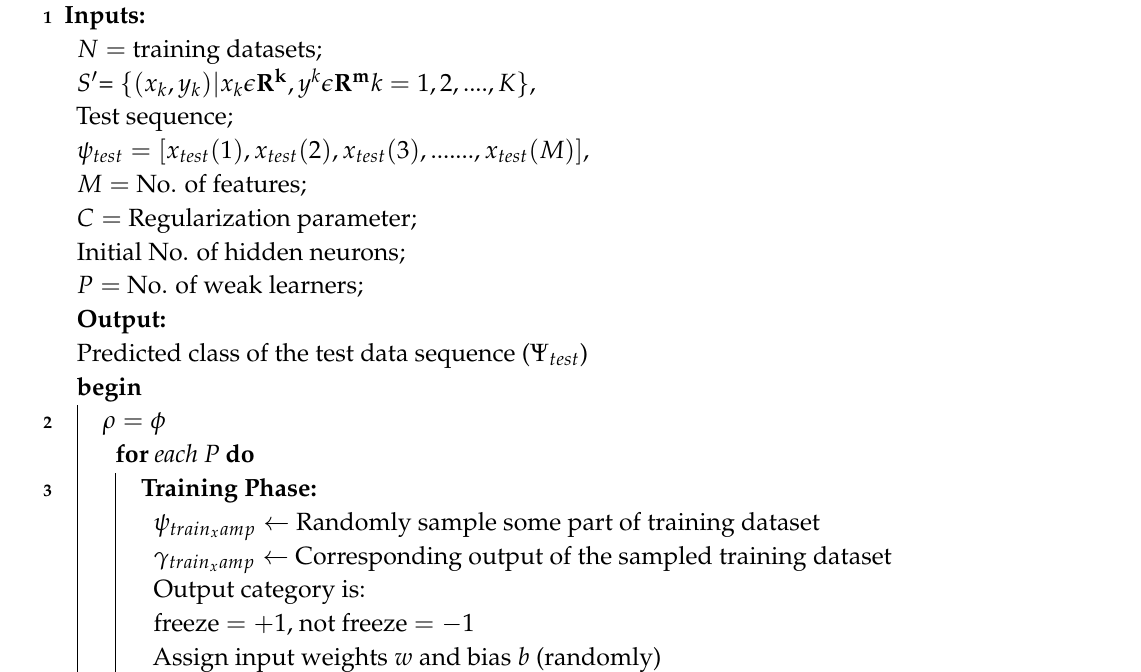
Algorithm 1: C-ELM with bagging